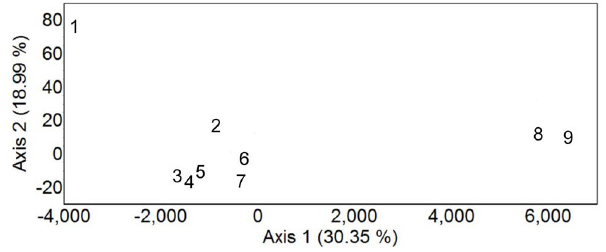
Figure 2. Factorial Correspondence Analysis (FCA) of nine sampled populations of Seaside Sparrow along the Gulf of Mexico. Site numbers are from Fig. 1.